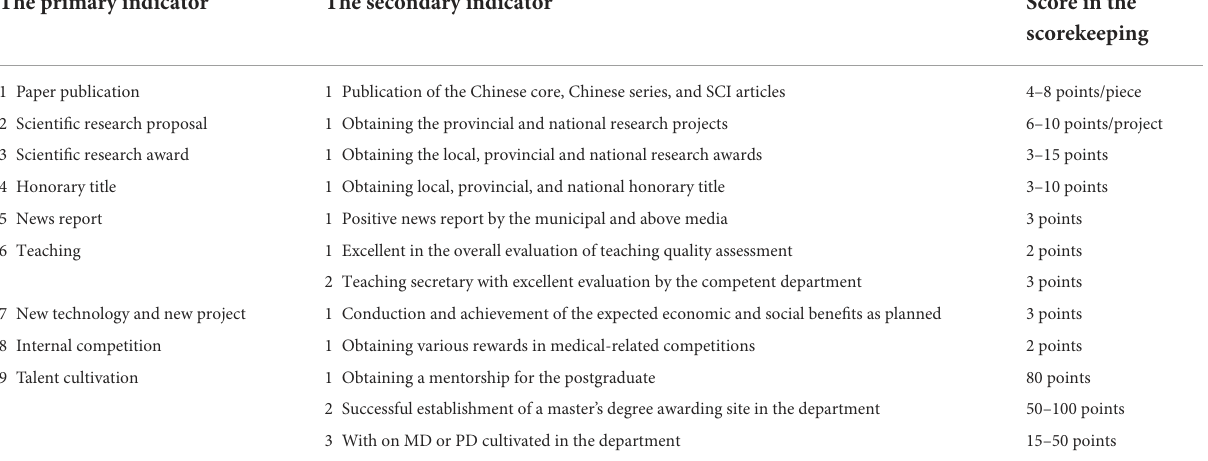
TABLE 2 The indicators in the annual scorekeeping assessment system for healthcare quality and safety (The incentive section in scorekeeping). The primary indicator